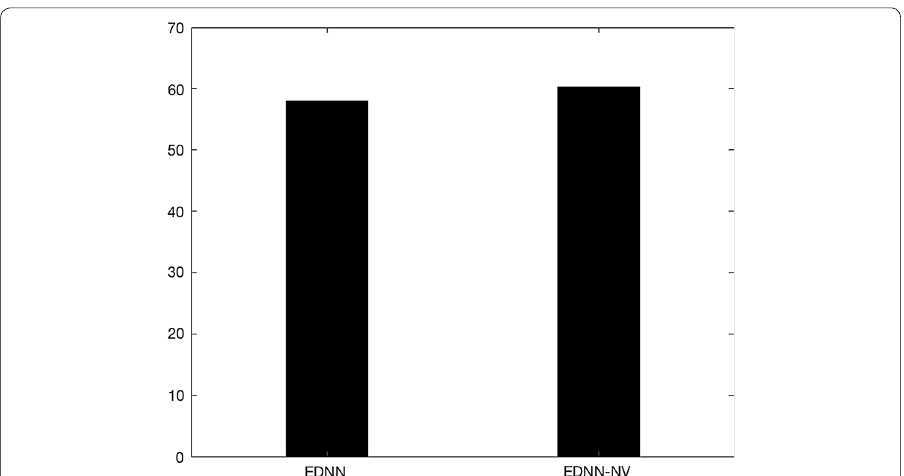
Fig. 5 Without using verb terms(EDNN-N) vs using verb terms(EDNN-NV) on our